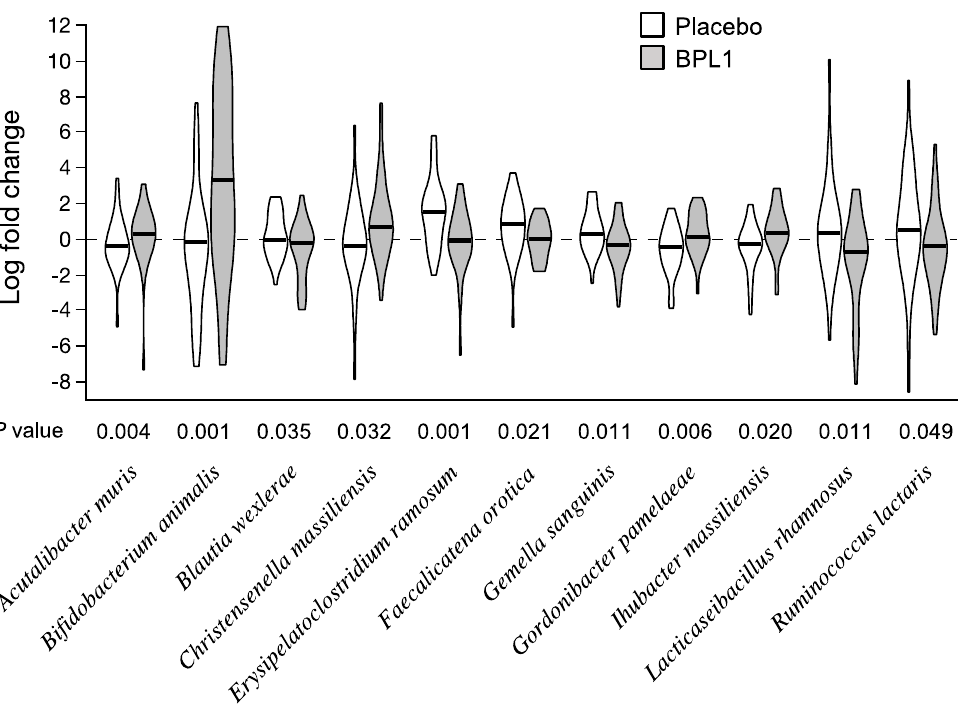
Figure 2. Changes in abundance of species during placebo and BPL1 treatment periods. Violin charts show log2 fold changes during placebo (white) and probiotic (grey) periods. Horizontal bars correspond to median values of log2 fold change. p values are from paired Wilcoxon signed-rank test between placebo and probiotic groups.